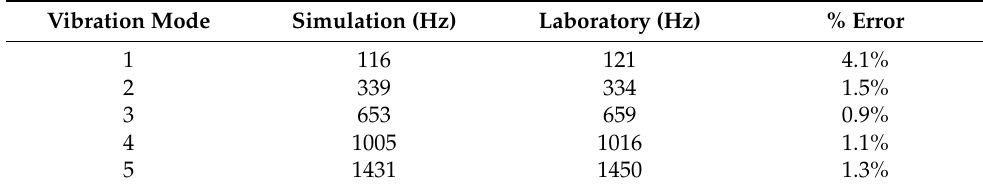
Table 6. Modal frequencies of the pantograph strip.